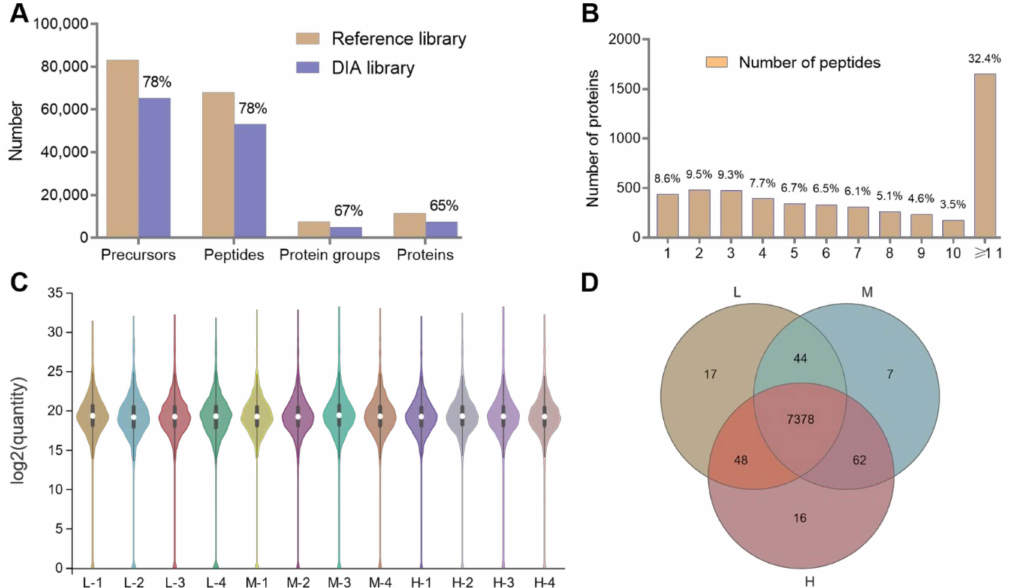
Figure 7. Summary of the proteomics data. Percentage of the DIA library compared to the reference library ( A ). Percentage of the number of peptides constituting the proteins ( B ). Normalization of protein quantification for samples of low (L), middle (M), and high (H) altitudes ( C ). Venn diagrams of identified proteins in low (L), middle (M), and high (H) altitudes ( D ). A total of 149, 71, and 137 DEPs were identified when comparing L and M, M and H, and L and H altitudes ( q < 0.05 and fold change ≥ 1.5 or ≤ 0.66). Of these, 66, 22, and 49 proteins were significantly up-regulated and 83, 49, and 88 proteins were